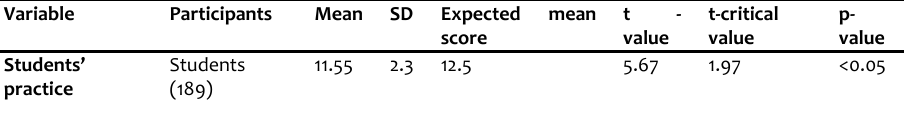
Table 5: Students’ practice of peer-led learning Variable Participants